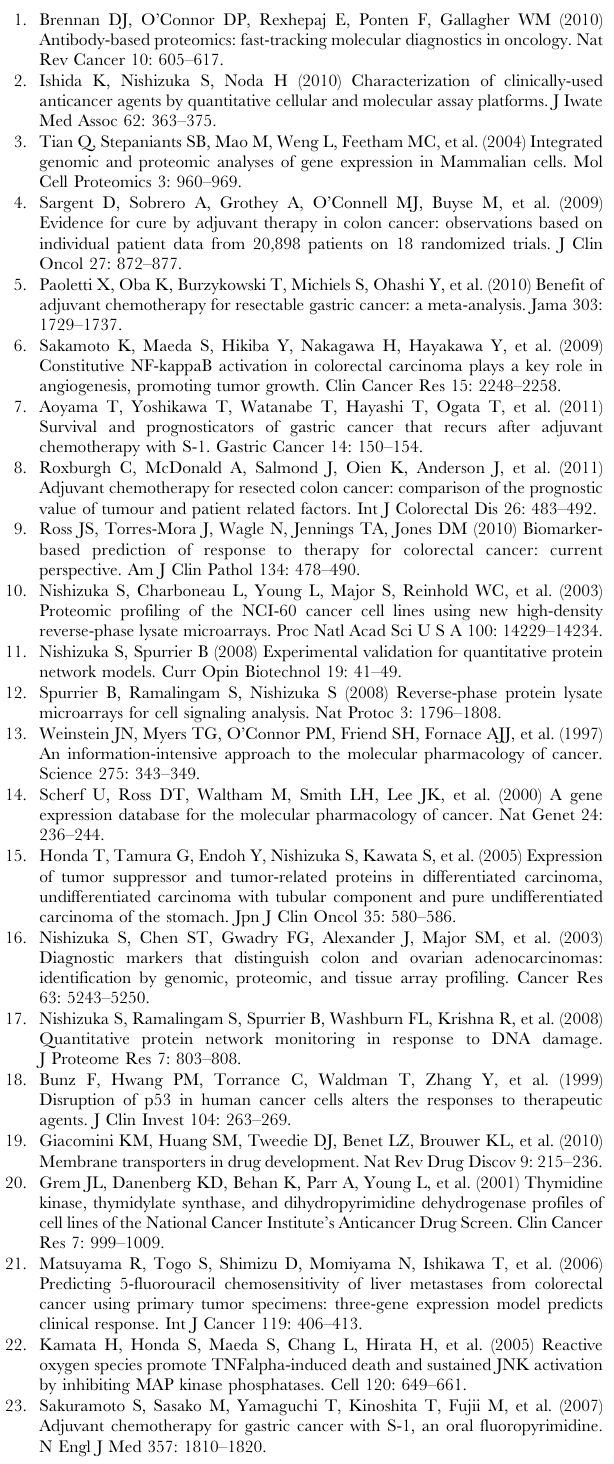
Table S3 Clinicopathological Features of the State of Relapse Table S4 Clinicopathological Features of Immunohis- tochemical